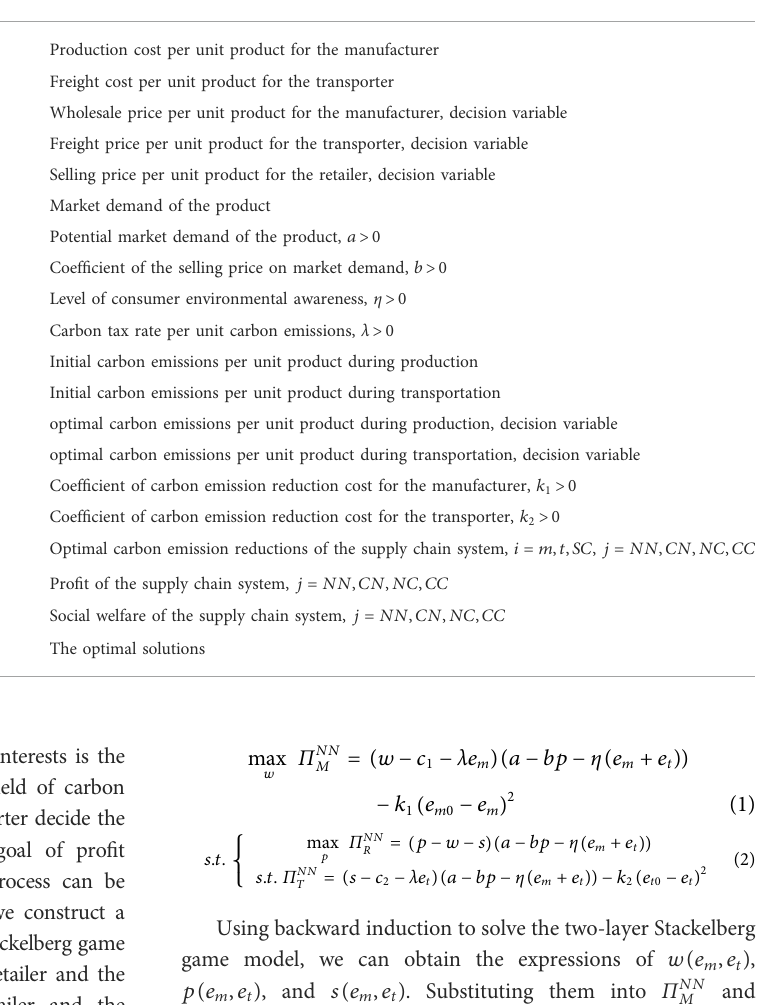
TABLE 2 Parameters and de fi nition.